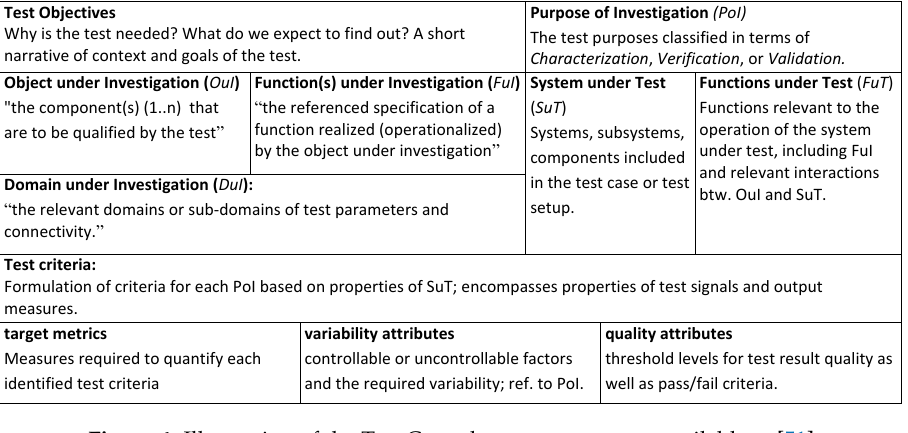
Figure 4. Illustration of the Test Case elements as canvas, available at